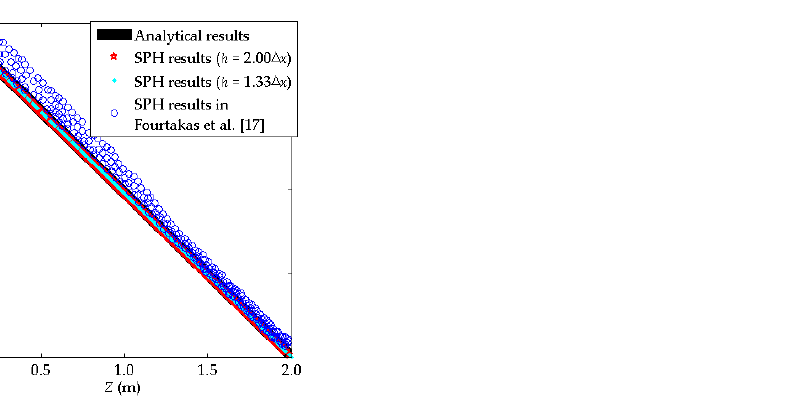
Figure 10. Pressure field in the STAR-CCM+ simulation ( 0.0125 m, 0.9 s) x t Δ = = .